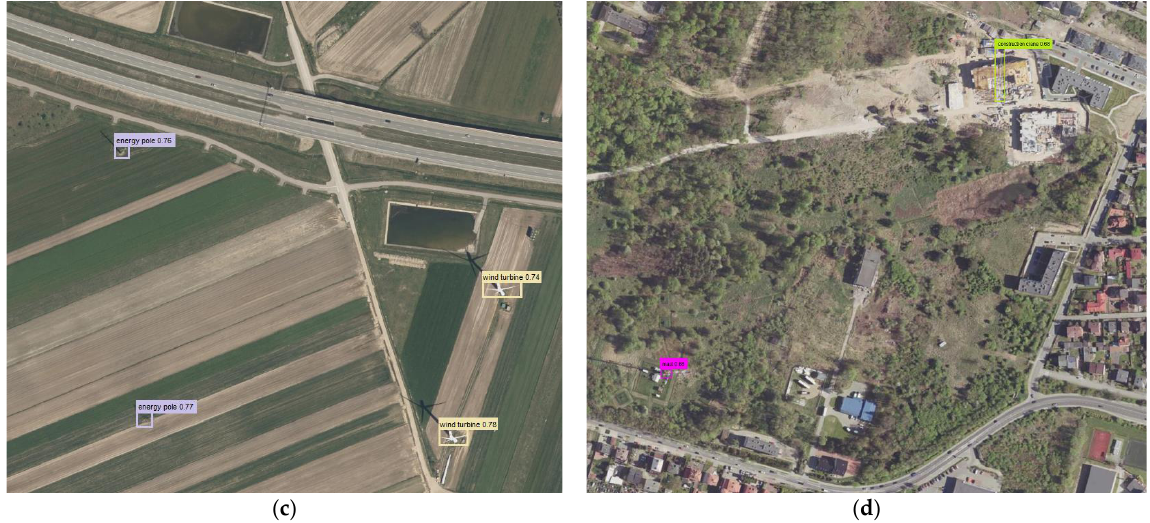
Figure 11. Sample detection (fragment of orthophotomap): ( a ) construction cranes; ( b ) wind turbines and energy poles; ( c ) wind turbines and energy poles; ( d ) construction crane and mast.